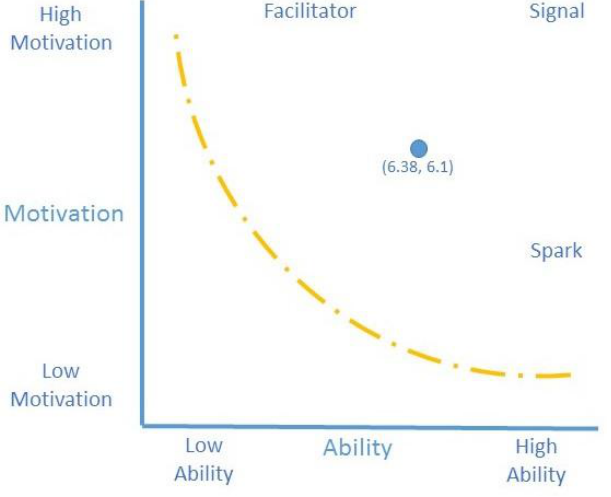
Figure 6. Location of current motivation/ability in